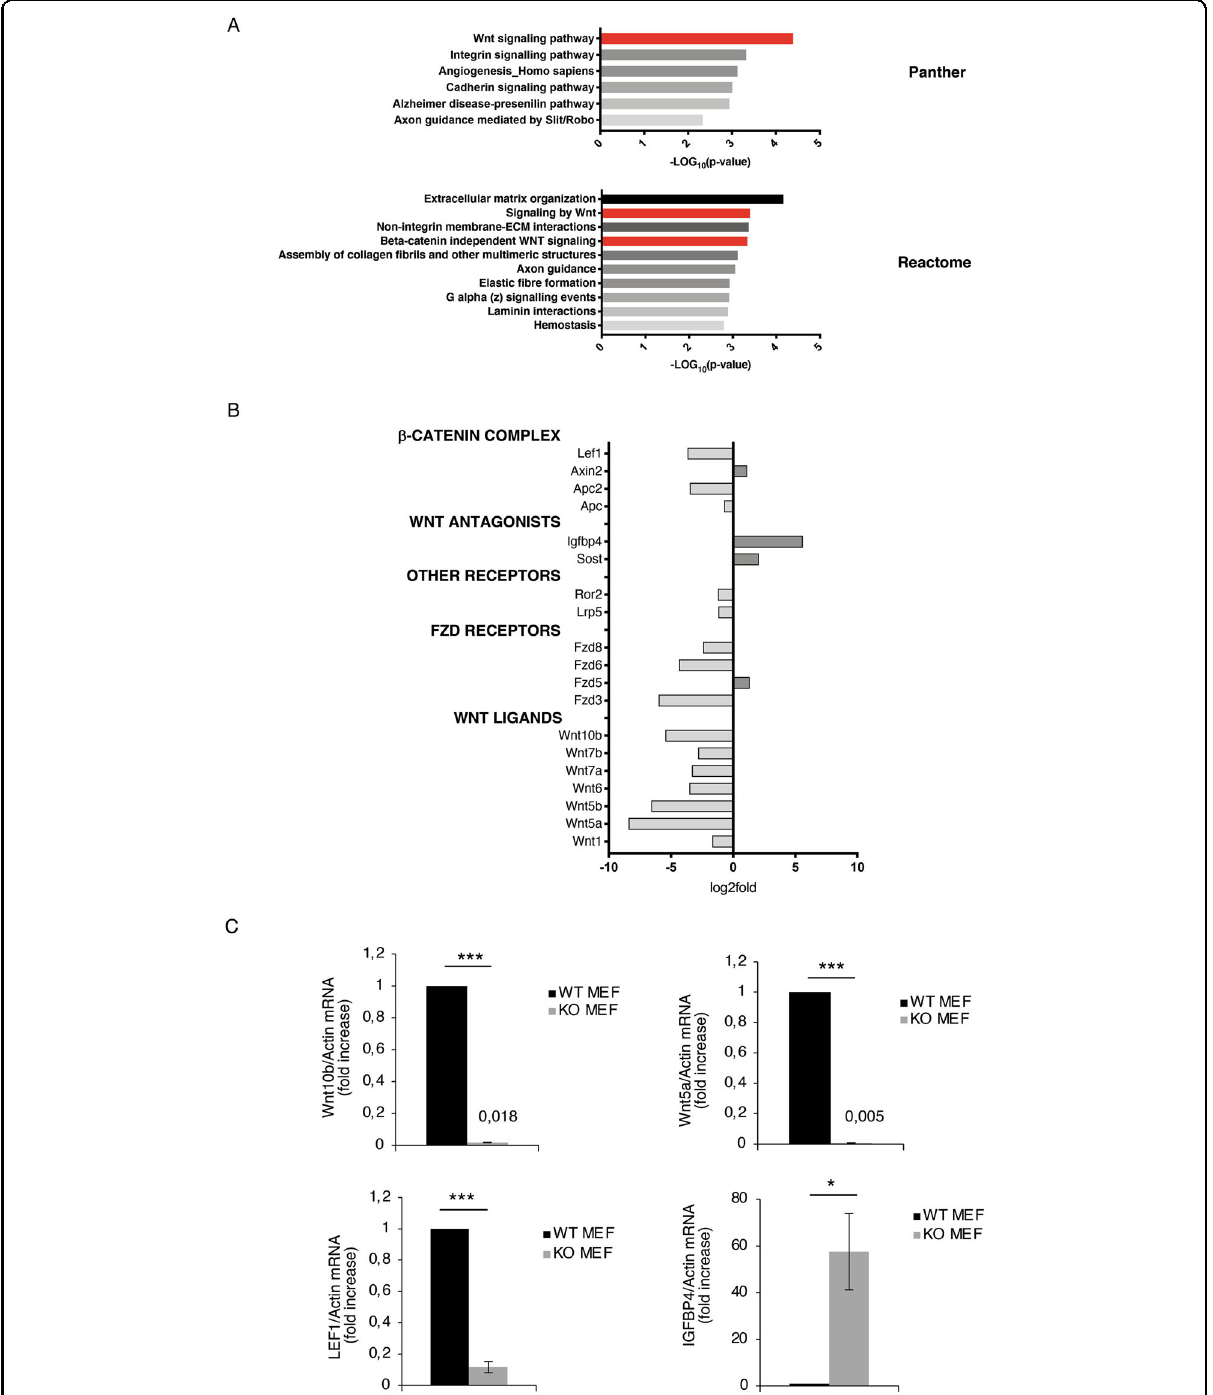
Fig. 2 Loss of TG2 modi fi es Wnt pathway. A Pathway enrichment analyses (expressed as − LOG10( p value)) using Panther or Reactome database of the signi fi cantly downregulated genes in KO MEFs compared with WT. B Plot of RNA expression (expressed as Log2 fold changes) of selected genes involved in β -catenin complex and Wnt pathway, comparing KO MEFs versus WT. C Wnt10b, Wnt5a, LEF1, and IGFBP4 mRNA levels, quanti fi ed by qPCR, in WT and KO MEFs. (* p < 0.05; *** p <